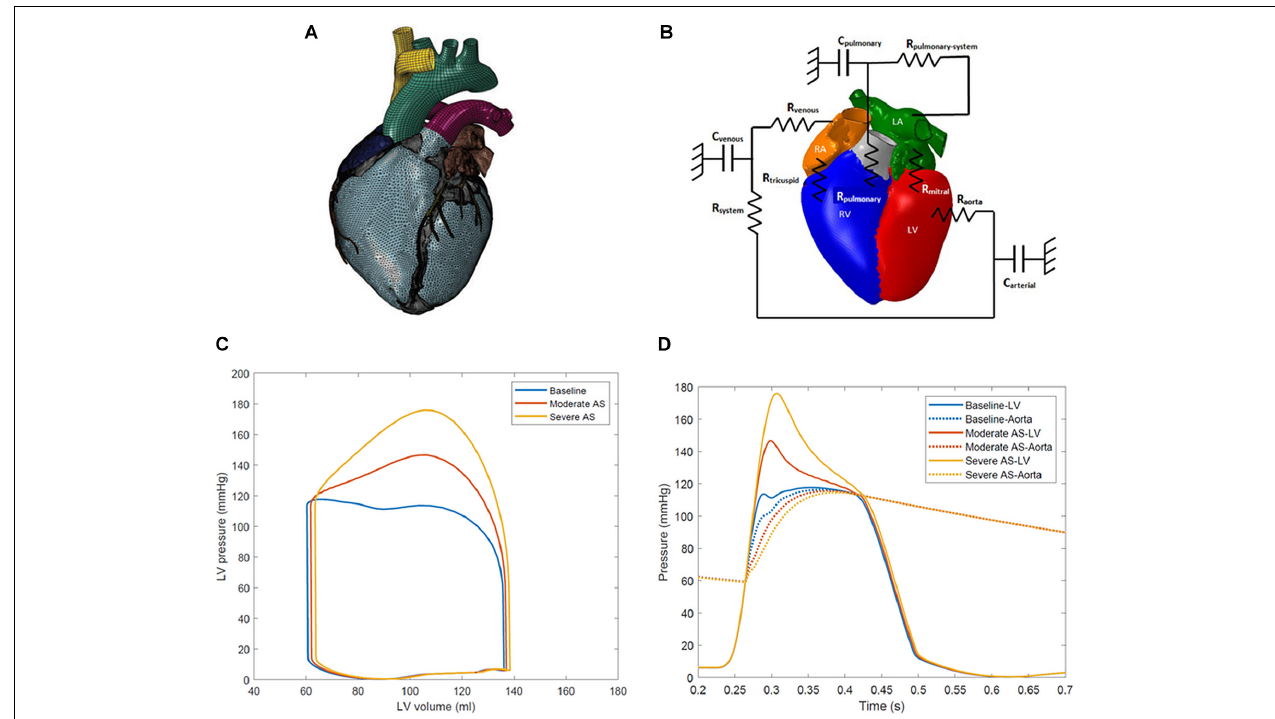
FIGURE 1 | (A) Solid finite element model of the human heart model. (B) Schematic representation of lumped parameter model of circulatory system fluid links and parameters. The term R aorta represents the aortic valve resistance parameter. R mitral , mitral valve resistance; C arterial , systemic arterial compliance; R system , systemic arterial resistance; C venous , venous compliance; R venous , systemic venous compliance; R tricuspid , tricuspid valve resistance; R pulmonary , pulmonary valve resistance; C pulmonary , pulmonary vascular compliance; R pulmonary–system , pulmonary vascular resistance. (C) Left ventricle pressure-volume loops for baseline, moderate aortic stenosis, and severe aortic stenosis conditions. (D) Left ventricle-aortic time pressure curves over one cardiac cycle. The systolic gradient between the left ventricle and aorta can be appreciated and serves as a marker of aortic stenosis